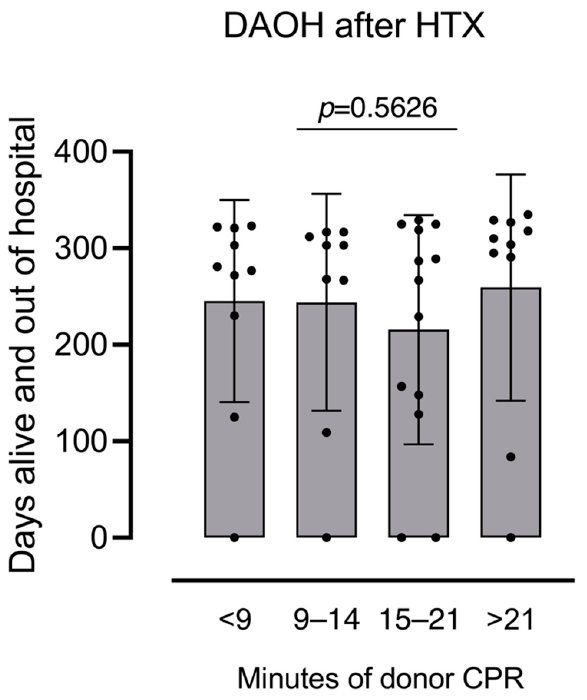
Figure 3. Days alive and out of hospital at one year after heart transplantation by quartile of cardiopulmonary resuscitation duration of donor